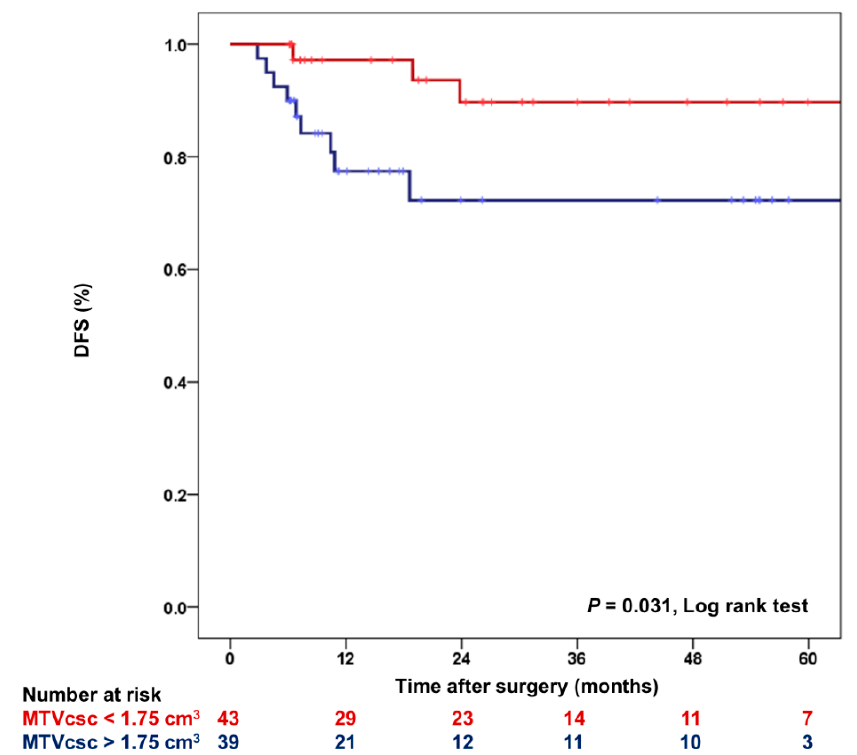
Figure 4. Kaplan-Meier plot for DFS according to MTVcsc in HER2-positive and TN subtypes. DFS: disease-free survival.